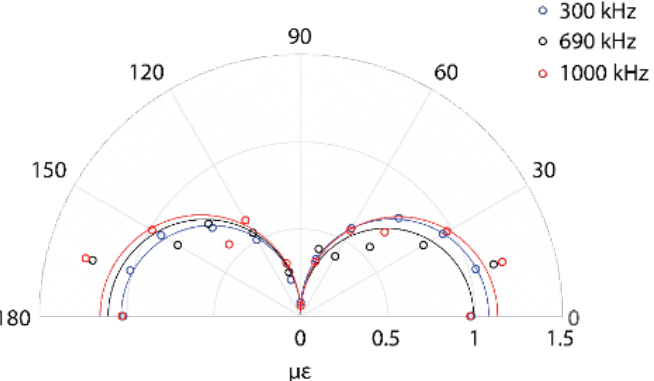
Figure 20. The angular response of remotely bonded FBGs to S 0 mode with different excitation frequencies plotted in a polar coordinate